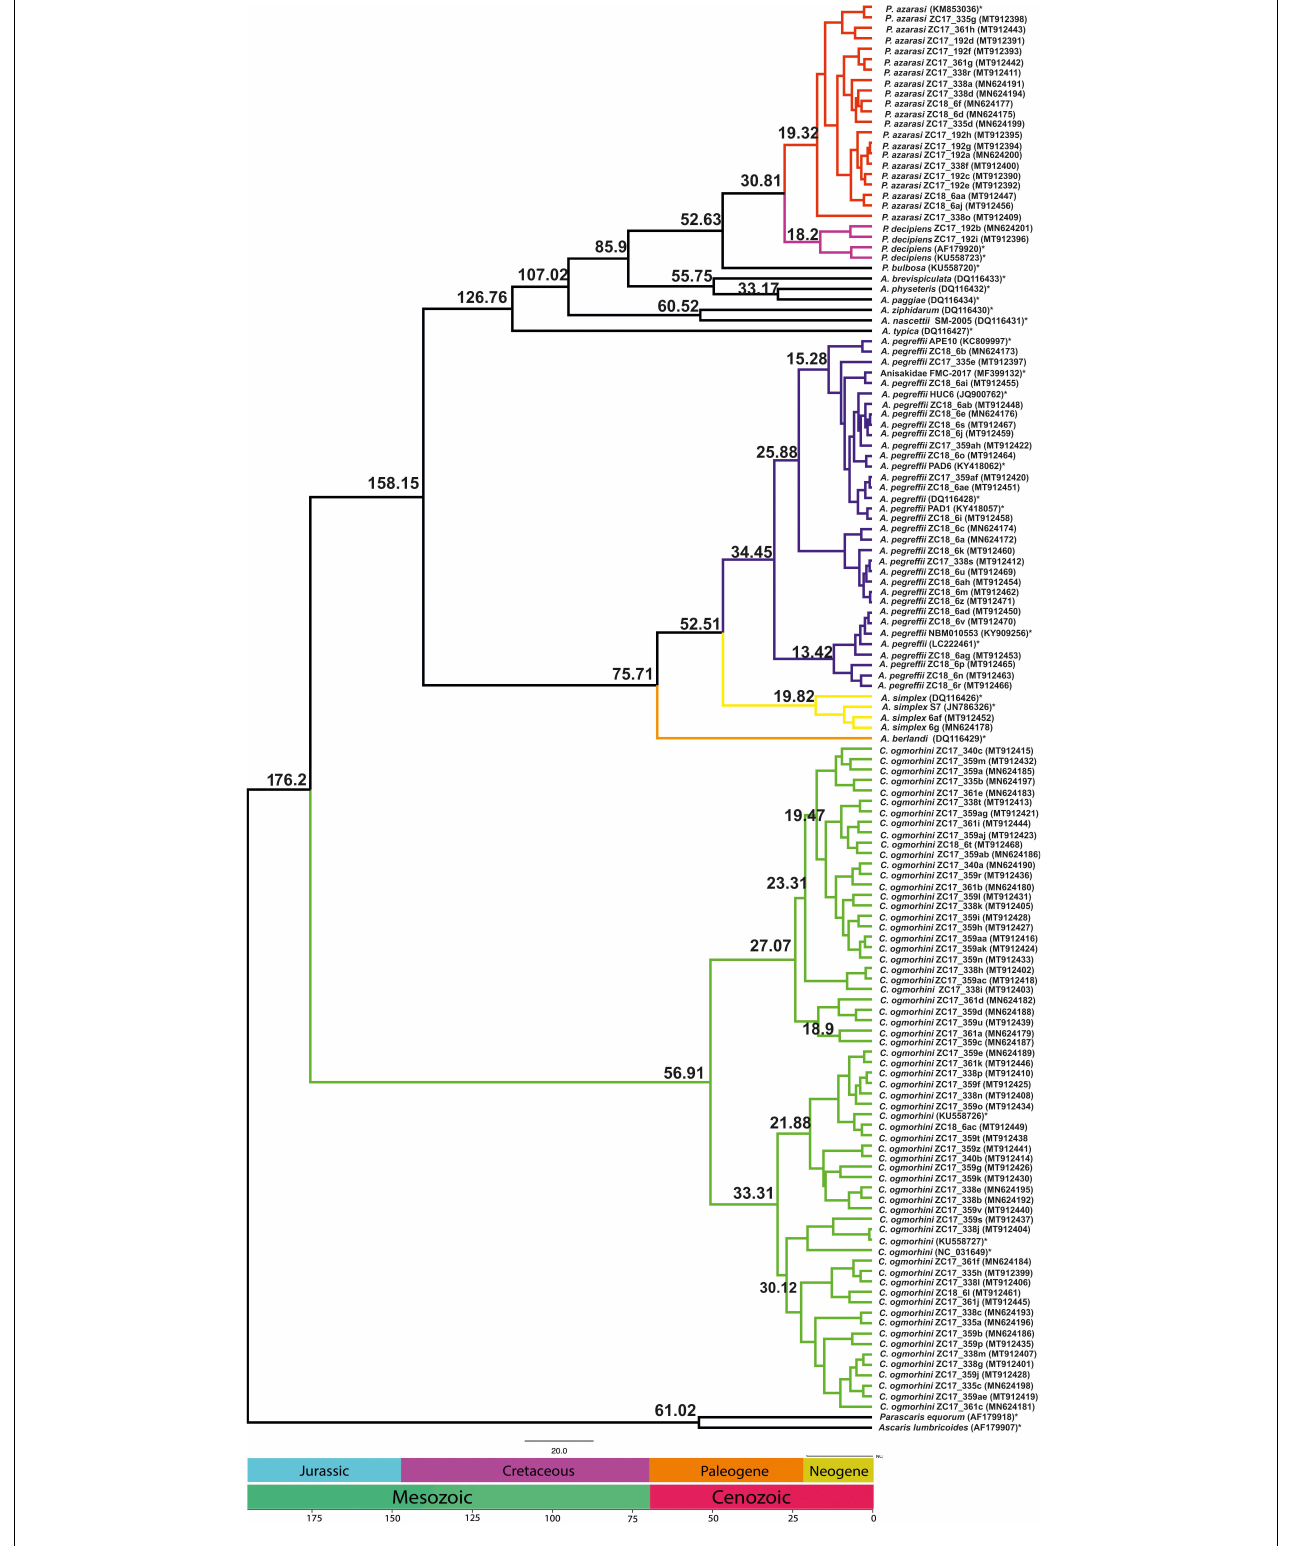
FIGURE 8 | Chronogram resulting from divergence time analyses using the concatenated cox2 dataset with 137 sequences using two outgroups (AF179918 and AF179907), generated by BEAST v1.8.2. Branch numbers display times of divergence.